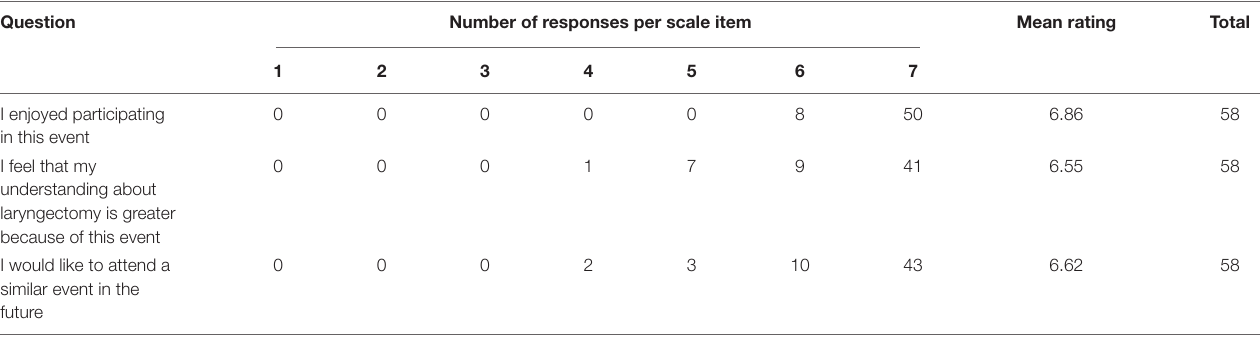
TABLE 5 | Final performance participants’ online evaluation.